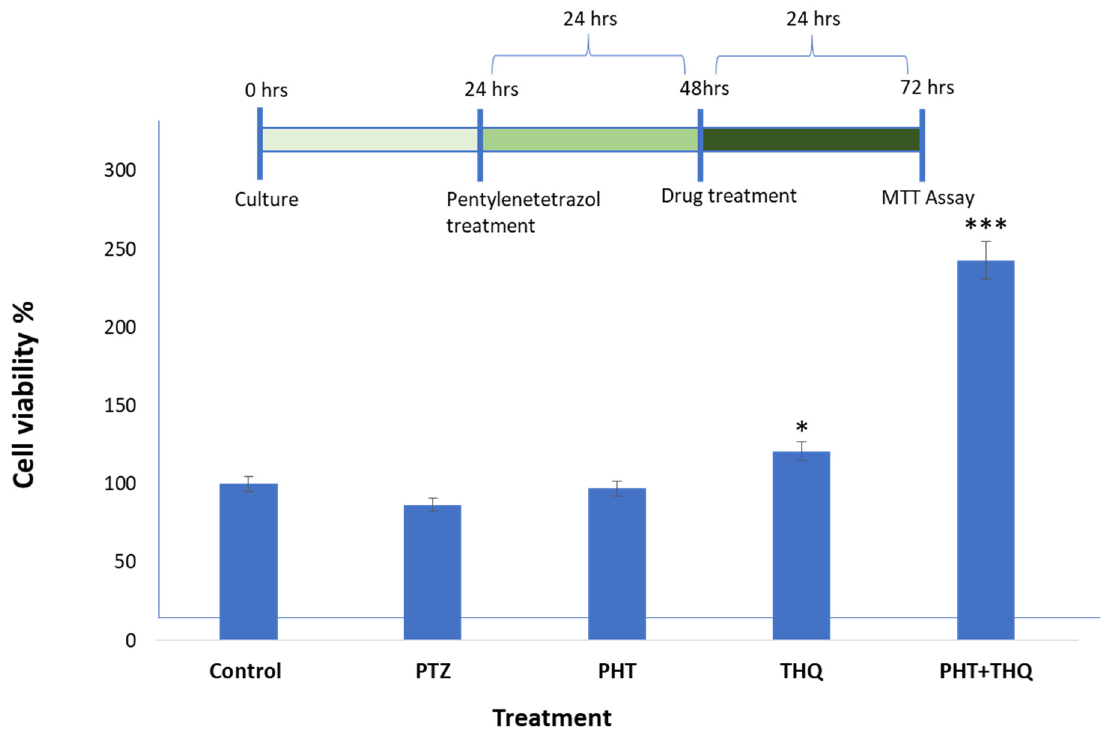
Figure 8. The complete cycle of treatment and the cell viability assay by MTT assay: control group (no drug treatment), PTZ (0.6 µg/mL), PHT (0.33 µg/mL), THQ (0.33 µg/mL), PHT + THQ (0.33 µg/mL + 0.66 µg/mL) * p < 0.01, *** p < 0.0001. PHT, THQ and PTZ indicate phenytoin, thymoquinone and pentylenetetrazol, respectively.